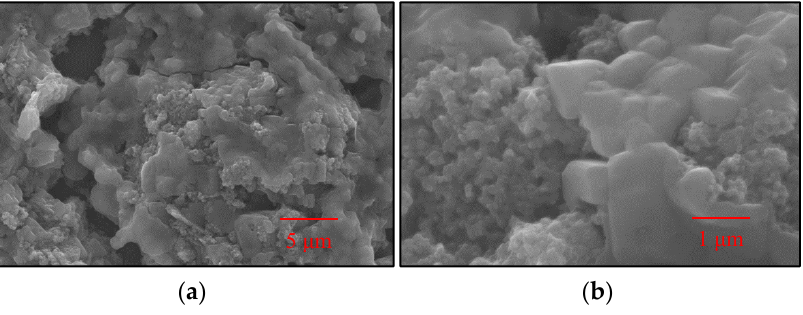
Figure 1. SEM images of slow release sulfide precipitant. ( a ) 10,000×; ( b ) 50,000×.